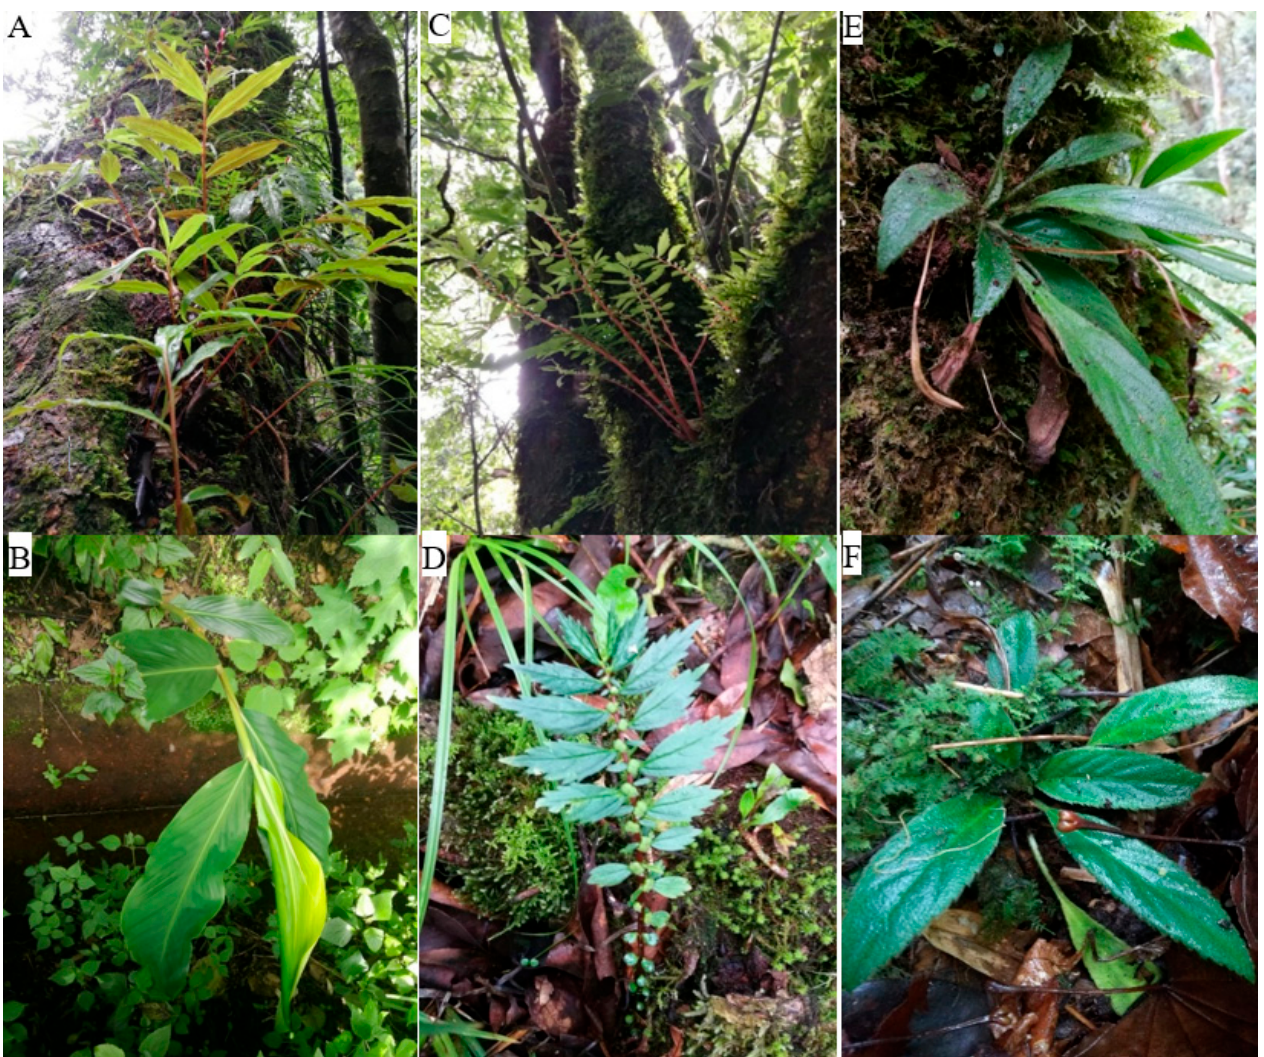
Figure 1. The pictures of investigated species. ( A , B ) epiphytic and terrestrial individuals of Cautleya gracilis , ( C , D ) epiphytic and terrestrial individuals of Elatostema monandrum , ( E , F ) epiphytic and terrestrial individuals of Briggsia longifolia , respectively.